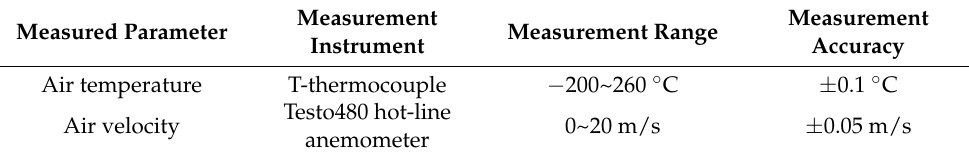
( c ) Figure 3. Physical view of the measurement instrument: ( a ) T-thermocouple; ( b ) Testo 480 hot-line anemometer; ( c ) Agilent. 2.2. Computational Fluid Dynamics (CFD) Simulation Experimental measurements and CFD simulations are the two main research meth- ods employed in this study to investigate the various indoor air distributions [29,30]. Ex- perimental measurement can provide realistic data, but this method is expensive and time-consuming. Thus, CFD simulation was added to this study. With the rapid develop- ment of computational capabilities, CFD simulations of lower cost are widely used to pre- dict indoor airflow, indoor air temperature, thermal comfort, indoor air quality, etc. [31]. Experimental measurements can be collected to validate the reliability of CFD simula- tions. The experimentally validated CFD simulations are used to produce data for the de- velopment and validation of response surface models. This is a common practice in the field of the built environment [32]. 2.2.1. Boundary Conditions To ensure the high quality of the CFD simulation of an indoor thermal environment, ver- ification and validation followed a standard procedure used in this study [33]. Airpak 3.0.16 was used to construct the physical model, generate mesh, and perform the simulation. To obtain reasonable accuracy and relatively high computational efficiency, the standard k- ε model was adopted in this study [34]. Compared with the RNG k- ɛ model